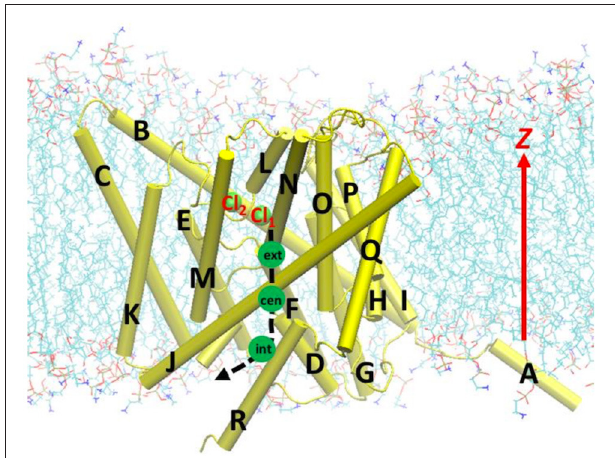
FIGURE 1 | Beginning geometry for steered molecular dynamics simulations, where the Cl − ion at the extracellular pore entrance (Cl 1 ) was moved toward the intracellular side along the path indicated by the black dash curve and arrow. Approximate positions of the three binding sites S ext , S cen , and S int were indicated by the green circles. Also shown is another nearby Cl − ion (Cl 2 ), which was attracted to Arg147 during the equilibration. The EcCLC antiporter transmembrane domain was illustrated in cartoon in yellow, with the helixes A–R labeled. Lipid molecules were depicted as lines (cyan, C; blue, N; red, O; and tan, P). For clarity, water molecules and ions are not displayed, except for the above two Cl − ion shown as green spheres.